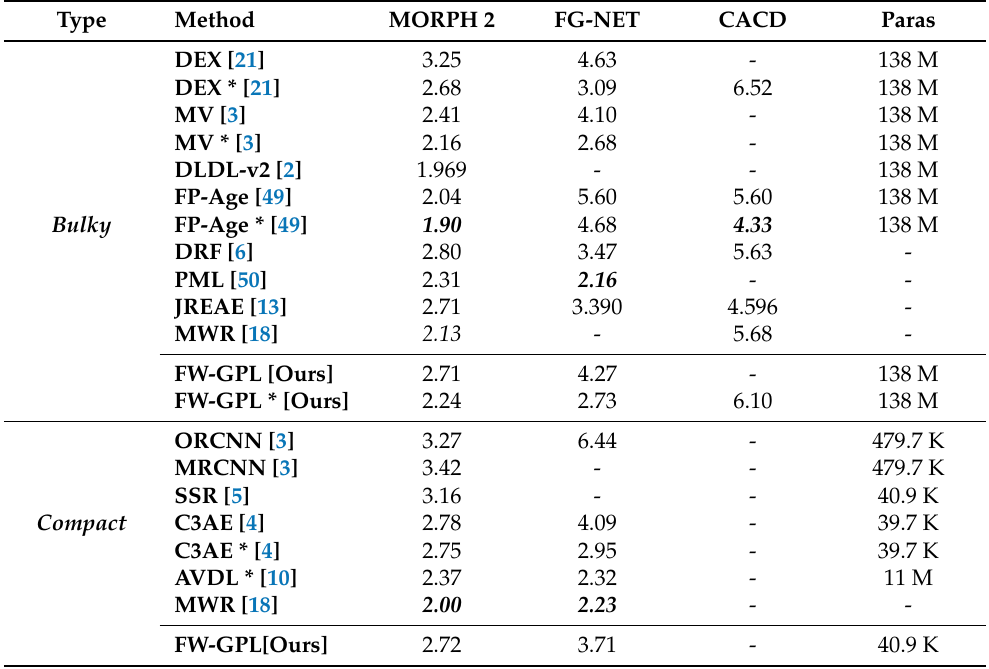
Table 5. In terms of MAEs, our approach is compared with different SOTA methods. (* indicates the model was pre-trained on the IMDB-WIKI